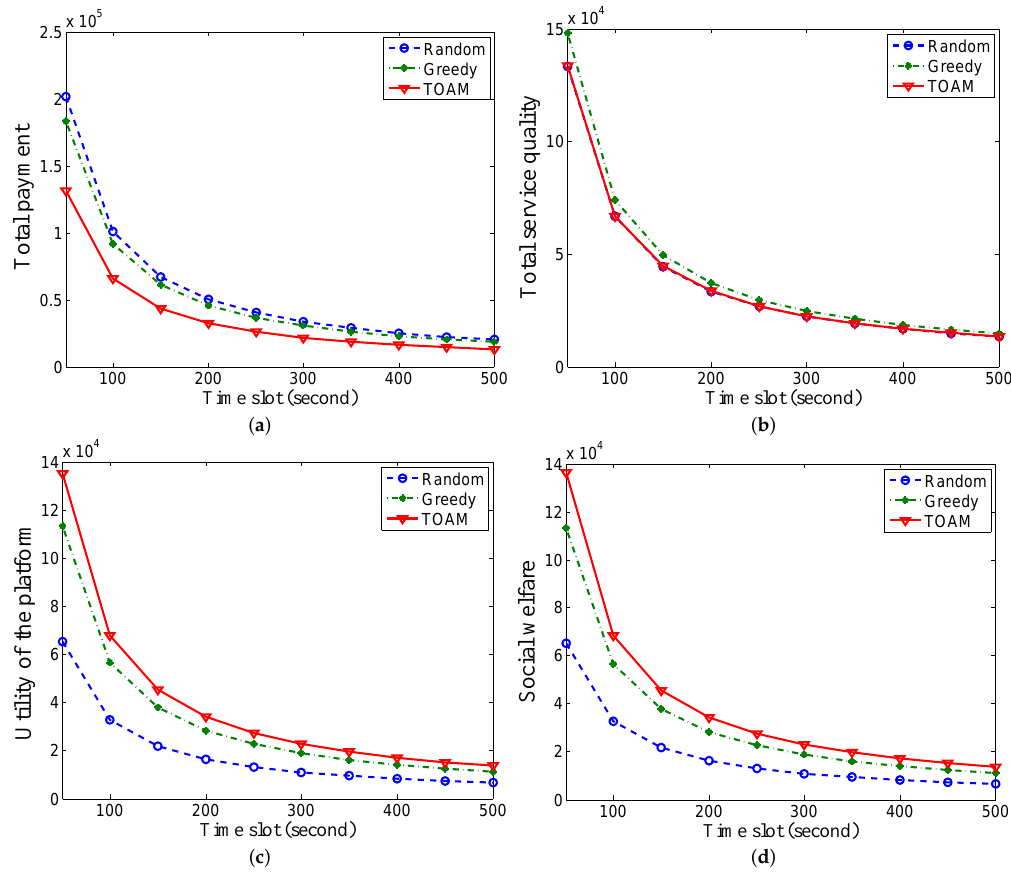
Figure 4. Performance comparisons under the MIT dataset with 100 users. ( a ) Comparison of average payment; ( b ) Comparison of average service quality; ( c ) Comparison of the average utility of the platform; ( d ) Comparison of average social